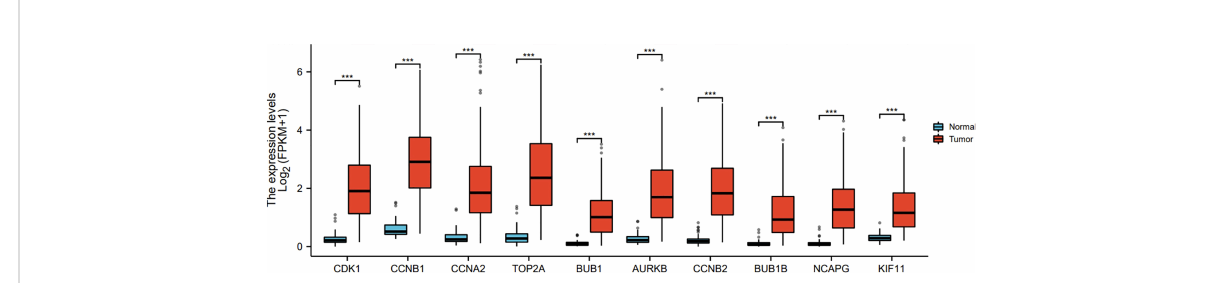
FIGURE 9 Hub gene expression was increased in HCC in TGCA database. The expressions of CDK1, CCNB1, CCAN2, TOP2A, BUB1, AURKB, CCNB2, BUB1B, NCAPG, and KIF11 were shown. ***P<0.001.